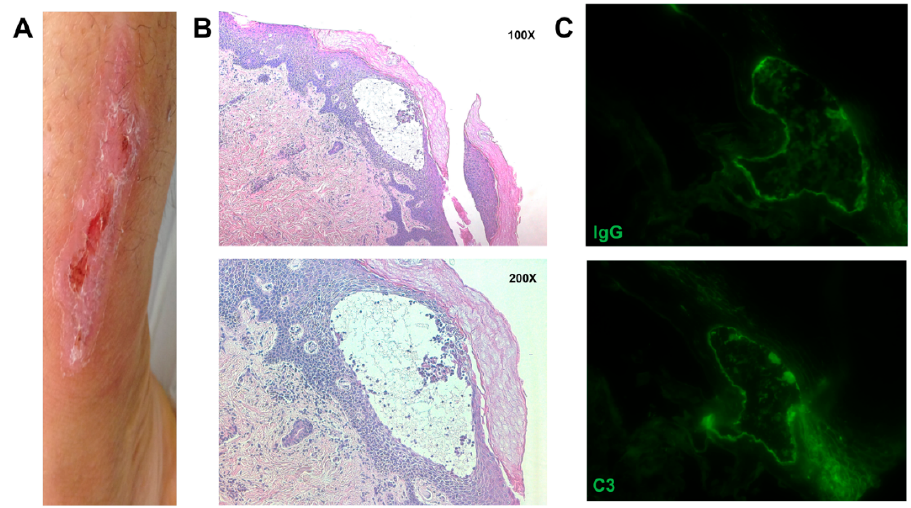
Figure 1. ( A ) Image showing the clinical skin manifestation of the patient with EBS. ( B ) IHC images showing intraepidermal blistering, mild spongiosis with associated inflammatory infiltrate (lymphoplasmacellular cells). Dermis shows mild inflammatory infiltrate of perivascular lymphocytes, magnification 100 × and 200 × . ( C ) Immunofluorescent analysis for C3 and IgG showing green signal at the dermo-epidermal junction, magnification 400 × .